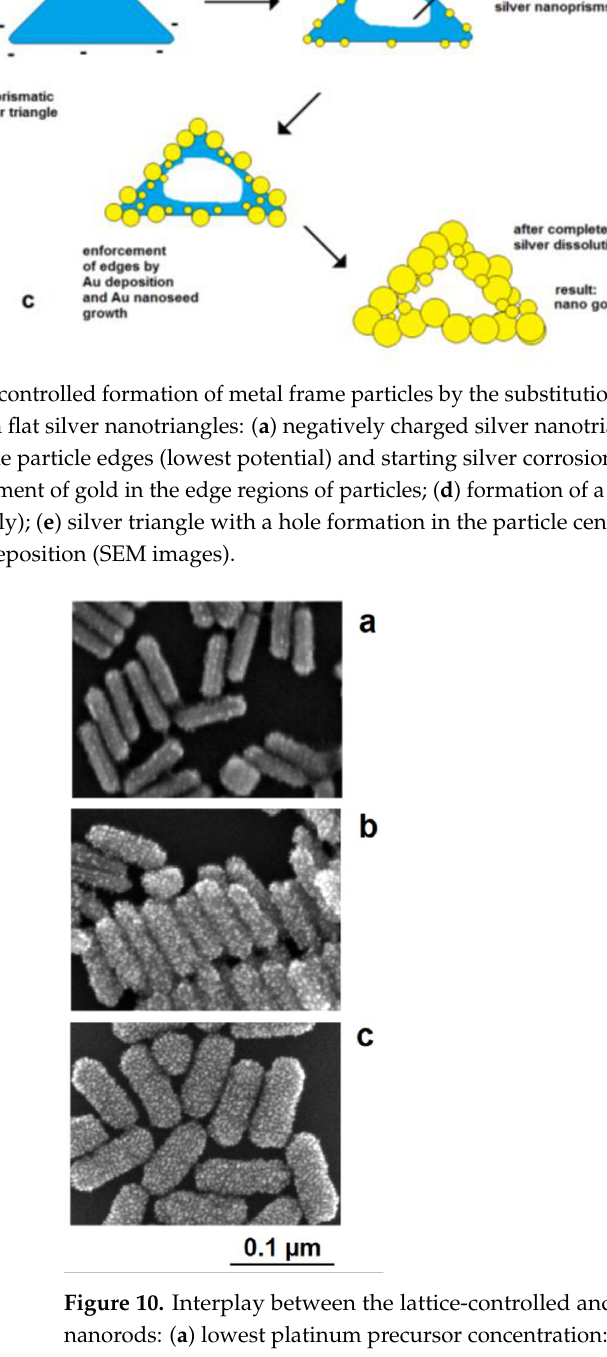
sified platinum deposition as a shell around the gold core. graphic planes; ( b ) mediate precursor concentration: additional nucleation on the crystallographic